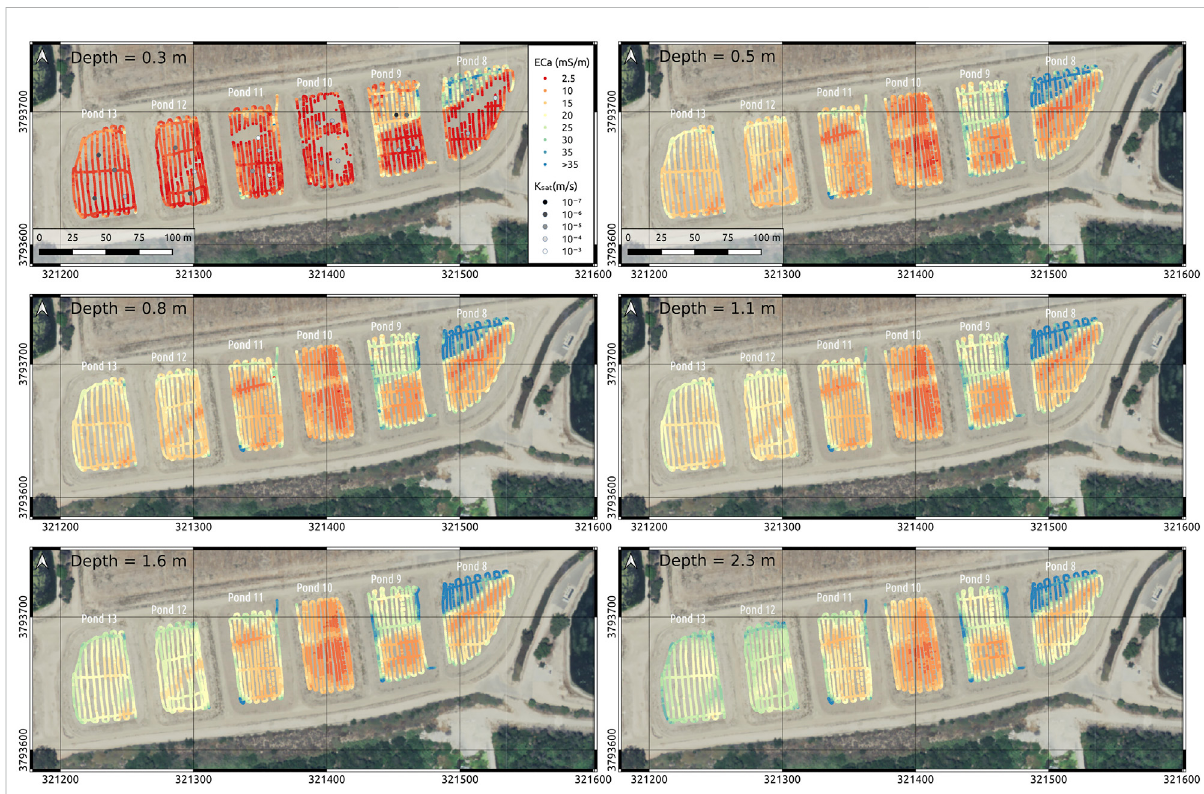
FIGURE 4 Apparent conductivity at 0.3 – 2.3 m depth measured using EMI. Note the differences in pond 8 and 9 where low and high conductivities are clearly separated. Shown are also the saturated hydraulic conductivities measured with the Guelph permeameter in the top left image (ECa at 0.3 m depth).